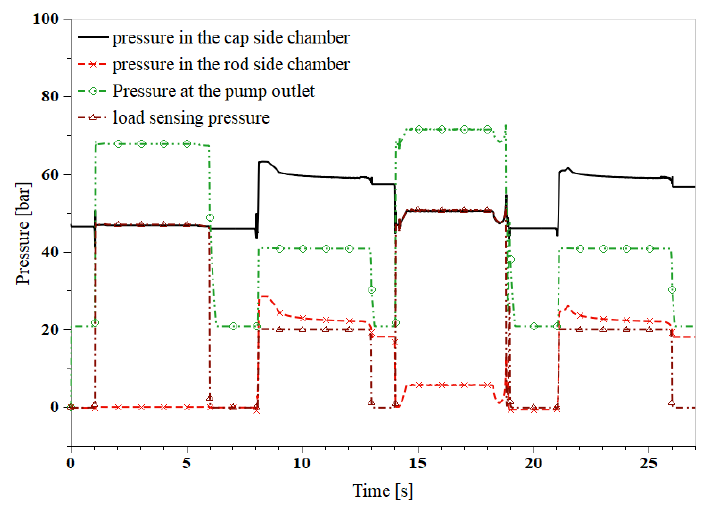
Figure 13. Boom cylinder and pump pressure curves of the proposed system with an empty bucket.